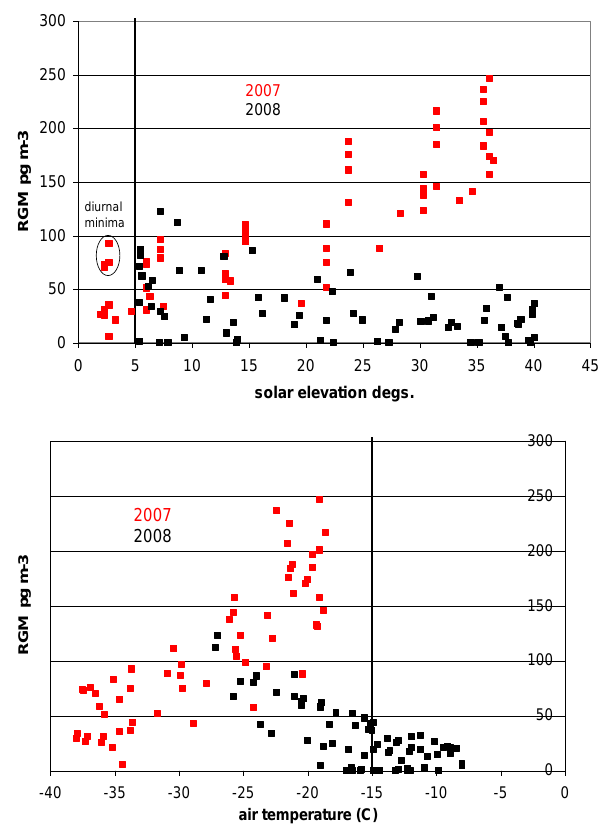
Fig. 10. RGM versus air temperature and RGM versus solar eleva- tion angle. Solar elevation and air temperature are shown with our modeled thresholds of 5 degree solar elevation and − 15 ◦ C.